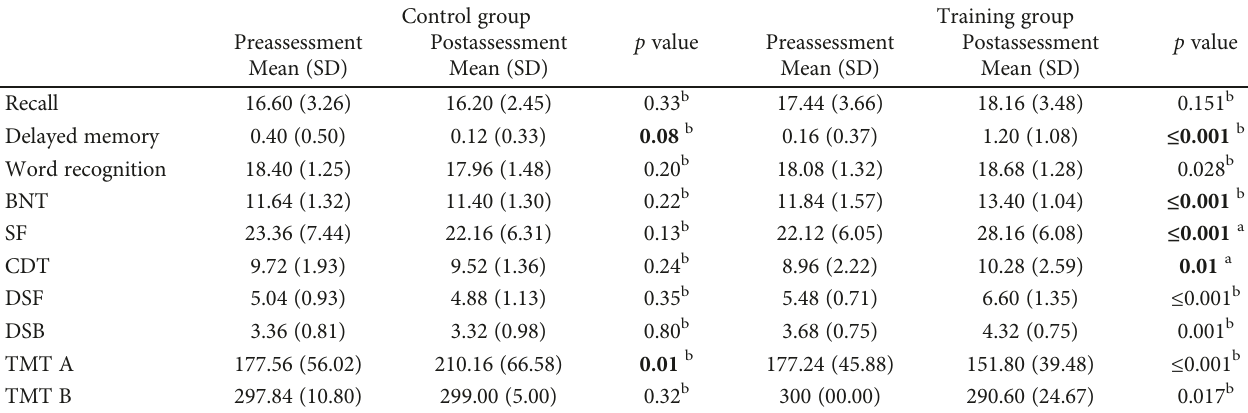
Table 3: Mean score, standard deviation, p value, and pre- and postassessment in the control and training groups.